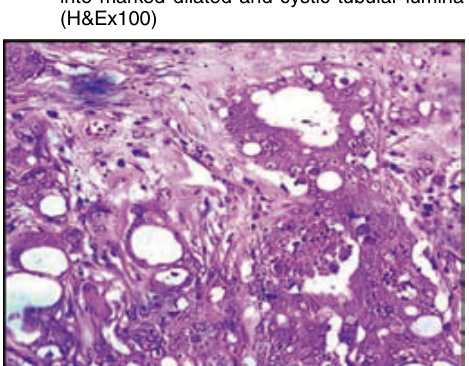
Fig.12. Carcinosarcoma – moderate infiltration of Tumour Associated Macrophages (H&Ex200)